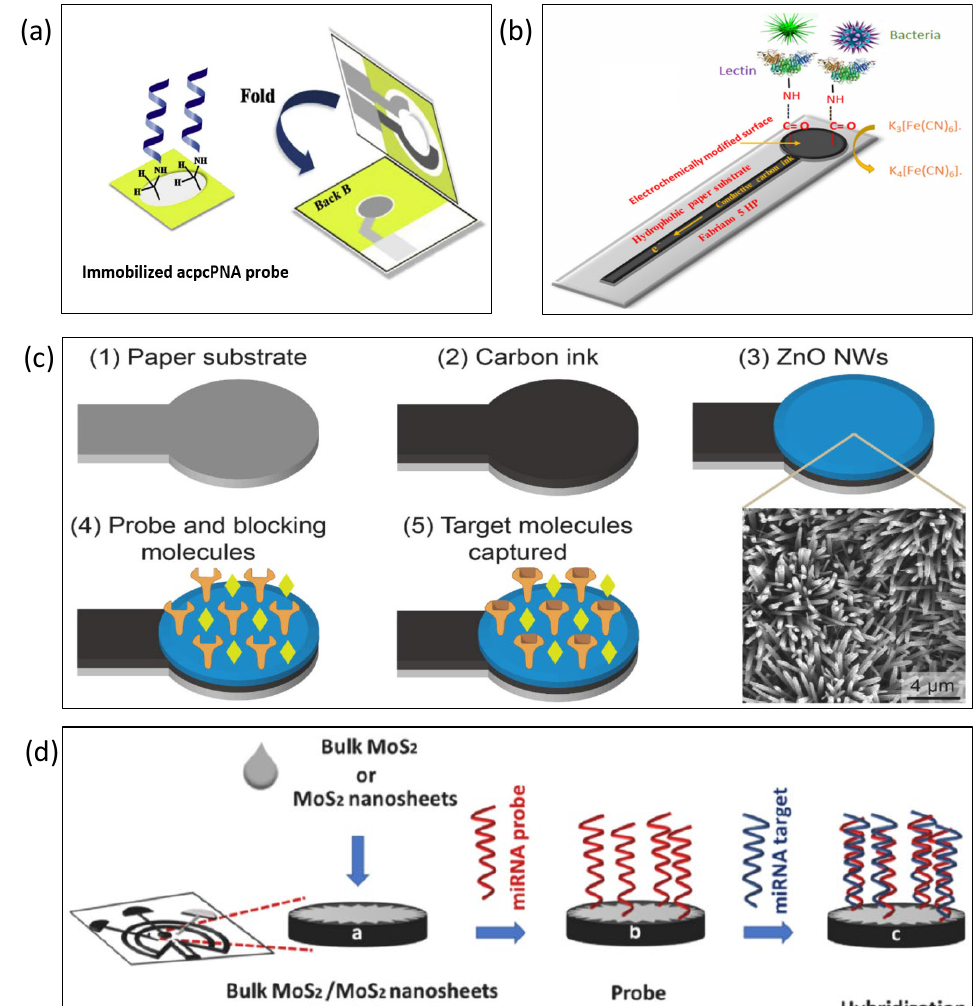
Figure 9. Paper-based impedance biosensors. ( a ) A paper-based electrochemical impedance DNA sensor was developed for tuberculosis detection. Reproduced with permission from [133]. Copyright Analytica Chimica Acta 2018. ( b ) Paper-based electrodes for impedance sensors were used to detect the bacteria in water. Reproduced with permission from [134]. Copyright Sensors and Actuators B: Chemical 2018. ( c ) A paper-based electrochemical impedance spectroscopy was designed to detect coronavirus (COVID-19). Reproduced with permission from [139]. Copyright Biosensors and Bioelectronics 2021. ( d ) Paper-based impedance sensor was used to sense miRNA-155 and miRNA-21 for early diagnosis of lung cancer. Reproduced with permission from [143]. Copyright Talanta 2022.